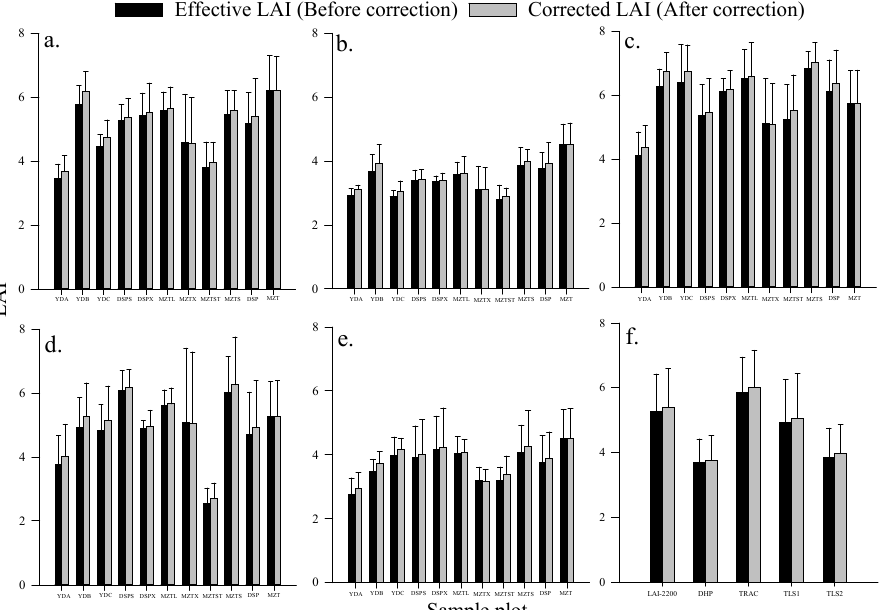
Figure 6. The estimated LAI before and after correction by different indirect methods (Mean ± SD). ( a ) LAI-2200; ( b ) DHP; ( c ) TRAC; ( d ) TLS1; ( e ) TLS2; ( f ) Total. TLS1 indicates TLS multi-station, and TLS2 indicates TLS